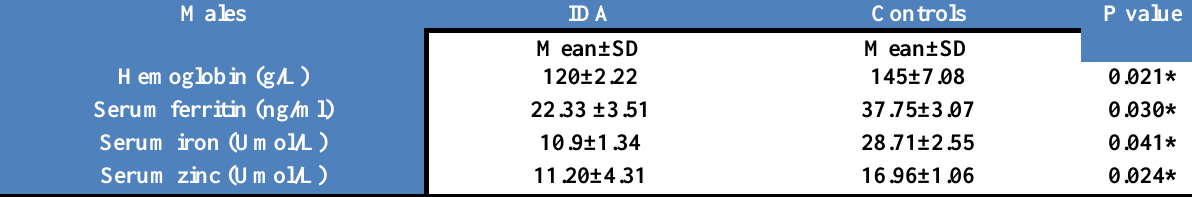
Table, 3: Some parameters for iron deficiency anemia with parasitic worms and control groups in males. Males IDA Controls P value Mean±SD Hemoglobin (g/L)